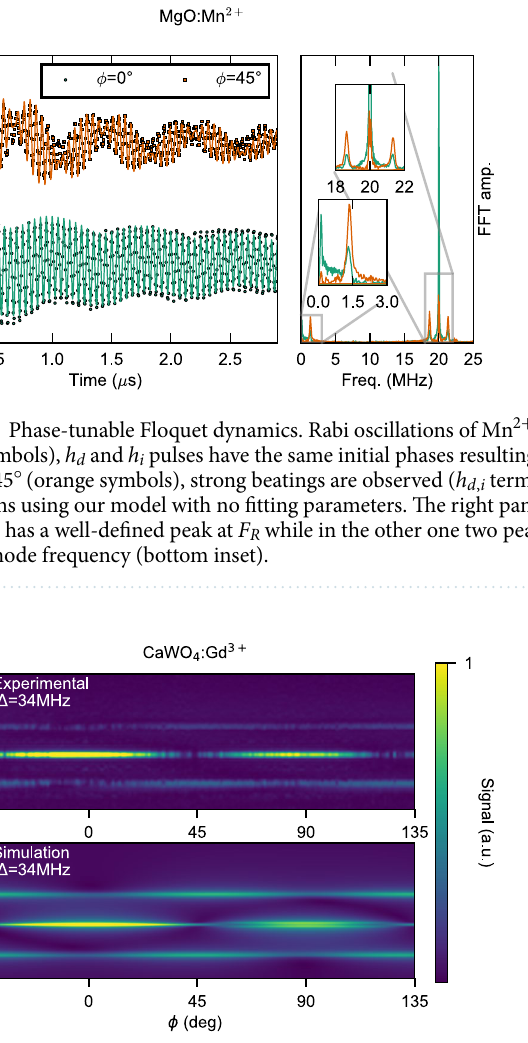
1 )π/ 4 a splitting of twice the ( 2 k = +